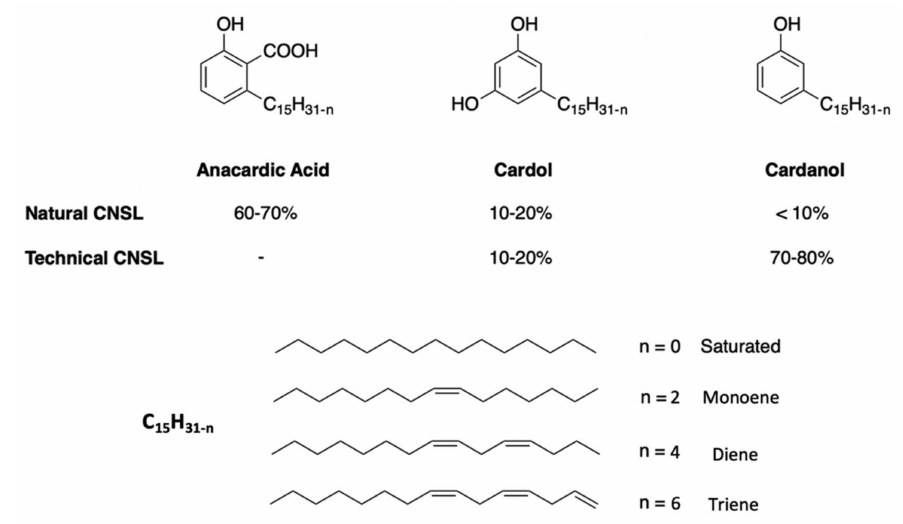
Figure 2. Chemical structures and compositions of the natural and technical CNSL’s